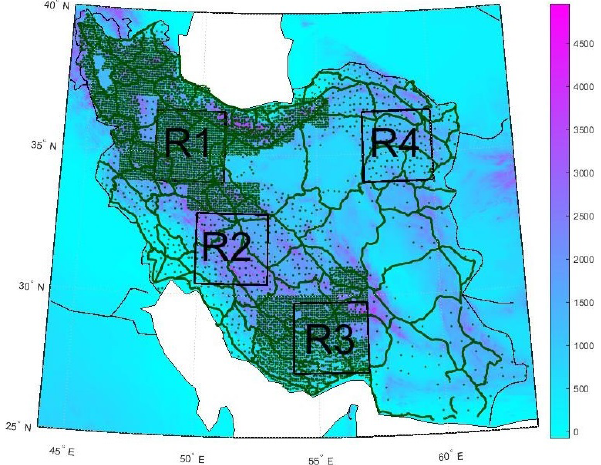
Table 2. Statistics of topographic height in each region